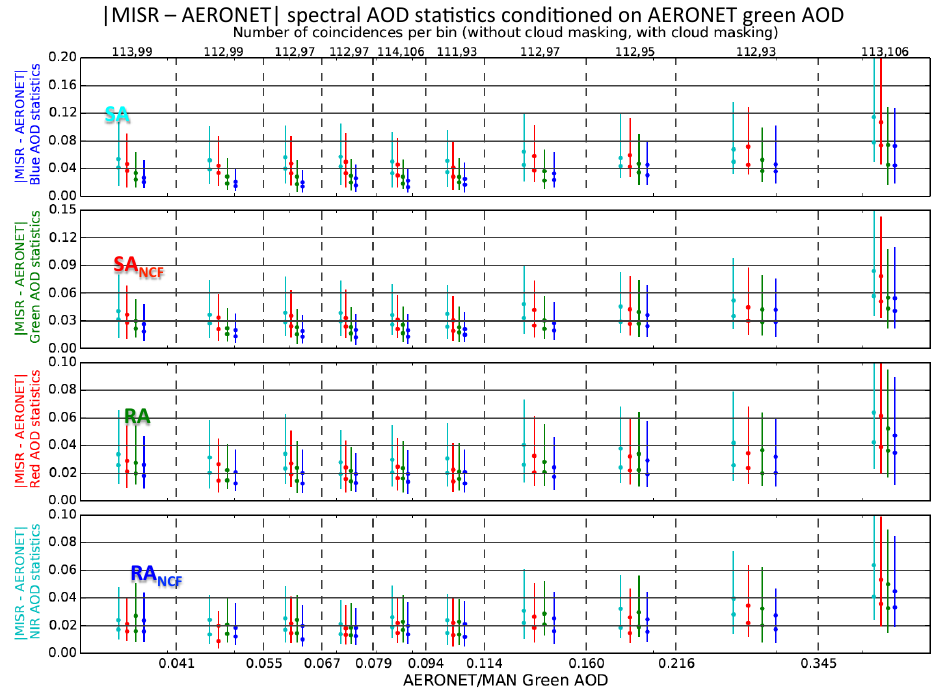
Figure 11. | MISR – AERONET | spectral AOD statistics conditioned on AERONET green AOD. For the vertical lines and points: cyan represents the SA, red represents the SA with enhanced cloud screening (FNC<0.50), green represents the RA with all modifications through Sect. 4.2, and blue represents the RA with all modifications and enhanced cloud screening (FNC<0.50). The vertical lines indicate the 25th–75th percentiles, and the lower dot gives the median absolute error. The upper dot represents the 68th percentile value. Each row of plots presents results for one of the four MISR spectral bands (blue, green, red, and NIR). The number of coincidences per AOD bin is listed at the top of the plot (without, and then with enhanced cloud masking). Vertical dashed lines separate AOD bins, which are defined based on the green band AOD. The upper limit of each (green band) AOD bin is shown at the bottom (except for the last AOD bin, which includes all higher AOD